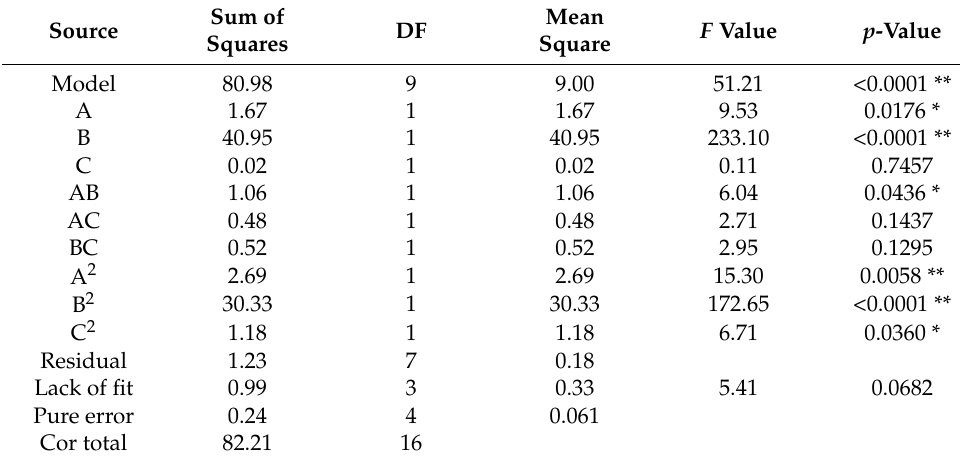
Table 4. Regression model variance analysis results of response